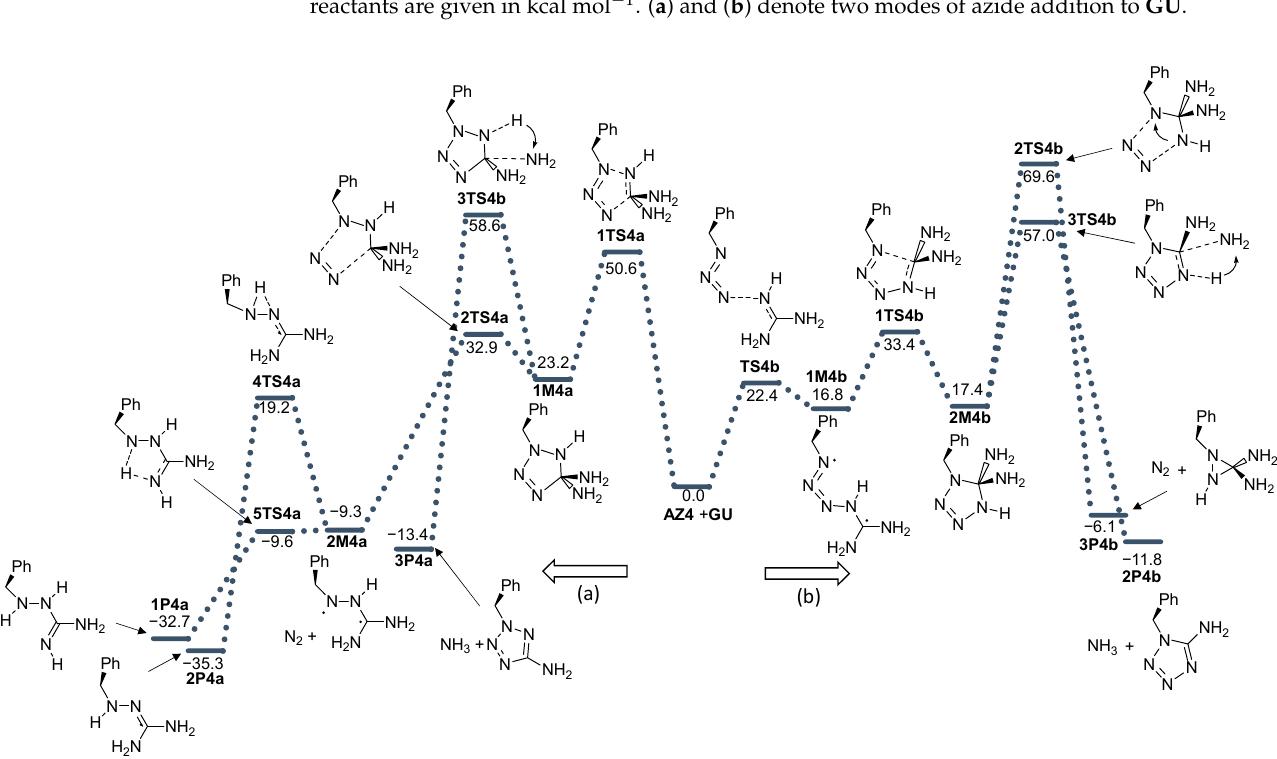
Figure 5. Energy profile for the addition of azide AZ3 with guanidine GU . Energies relative to reactants are given in kcal mol − 1 . ( a ) and ( b ) denote two modes of azide addition to GU .